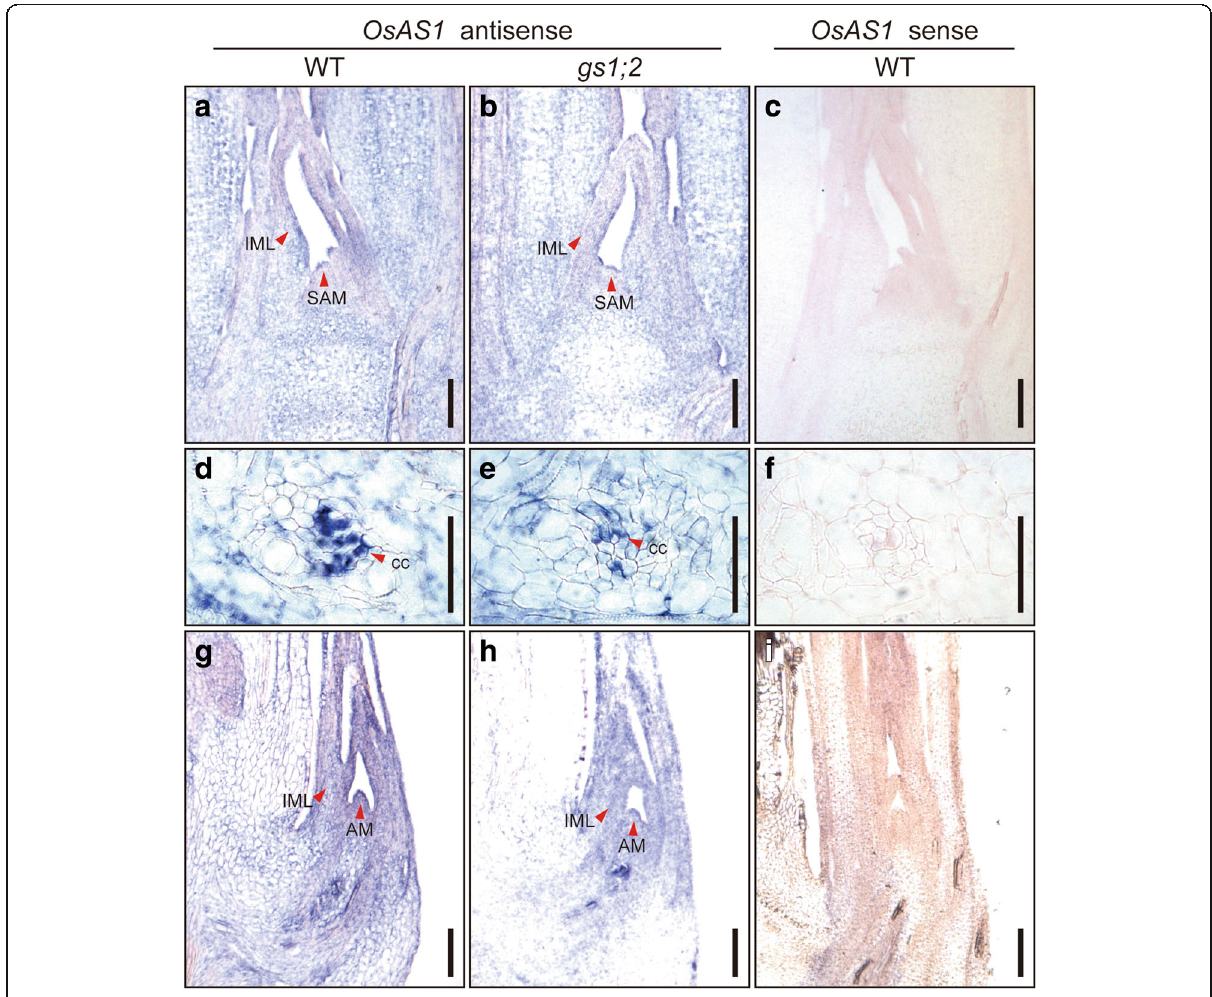
Fig. 2 In situ hybridization for OsAS1 in the basal portions of wild-type and gs1;2 mutant shoots. Longitudinal sections of basal portions of shoots were prepared from the wild-type rice (WT) ( a , c , d , f , g , i ) and from gs1;2 mutants ( gs1;2 ) ( b , e , h ) grown hydroponically in the presence of 1 mM NH 4 Cl until the fourth-leaf stage. A sense probe was hybridized to WT sections ( c , f , i ) as a negative control. Red arrowheads indicate hybridization signals for OsAS1 transcripts in the shoot apical meristem (SAM) ( a , b ), phloem companion cell of the nodal vascular anastomoses (cc) ( d , e ), an immature leaf (IML) area ( a , b , g , h ), and the tiller containing the axillary bud meristem (AM) ( g , h ). Note that the signal intensity in gs1;2 ( e ) was far weaker than in the WT ( d ). Scale bars = 100 μ m ( a - c , g - i ) and 50 μ m ( d - f